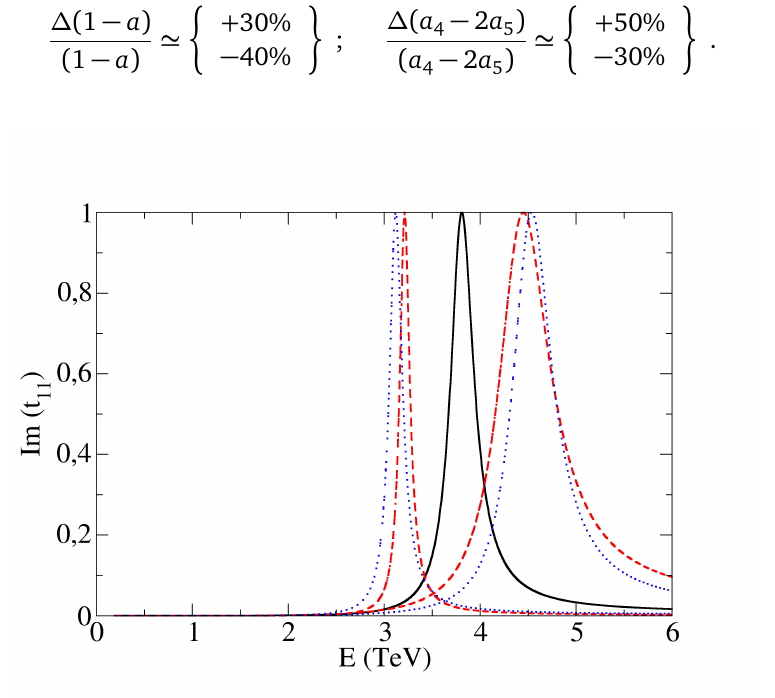
Figure 7: Solid line in the middle: vector-isovector resonance generated with the HEFT Lagrangian with parameters a = 0.95 and ( a The mass of the resonance turns out to be about 3.8 GeV. Dashed lines to either side (red online): recalculated resonance with a = 0.965 and a = 0.93. Dotted lines (blue online): alternatively, a is fixed at 0.95 and a decreased by 30%, respectively, with similar result. (The larger the separation from the Standard Model values a = 1, a